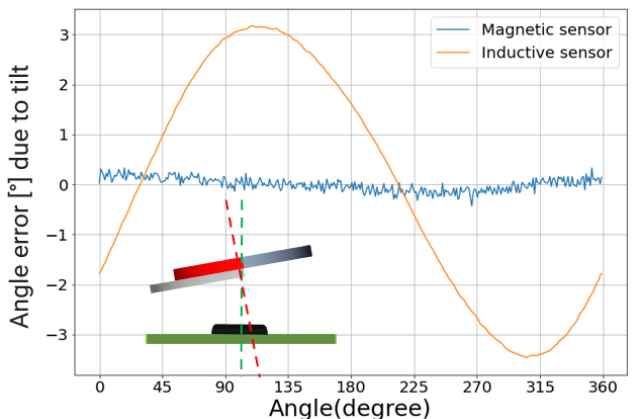
Figure 11. Angle error curves due to 1 ◦ of tilt. The impact is much larger on the inductive sensor. The inset depicts the configuration. The dotted green line is the center line through the sensor center. The dotted red line is the center line through the target